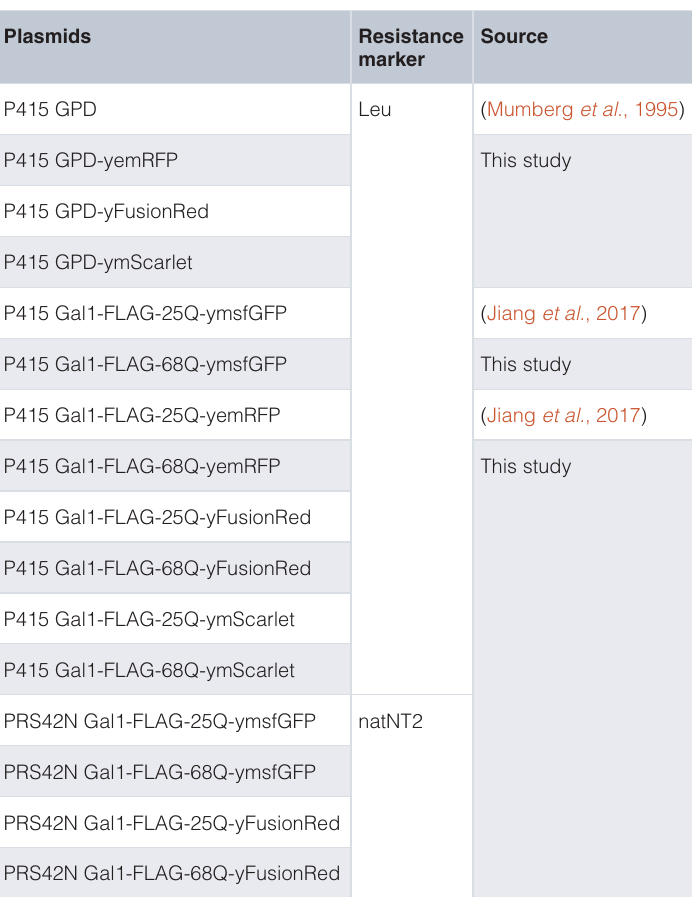
Table 1. Plasmids used in this